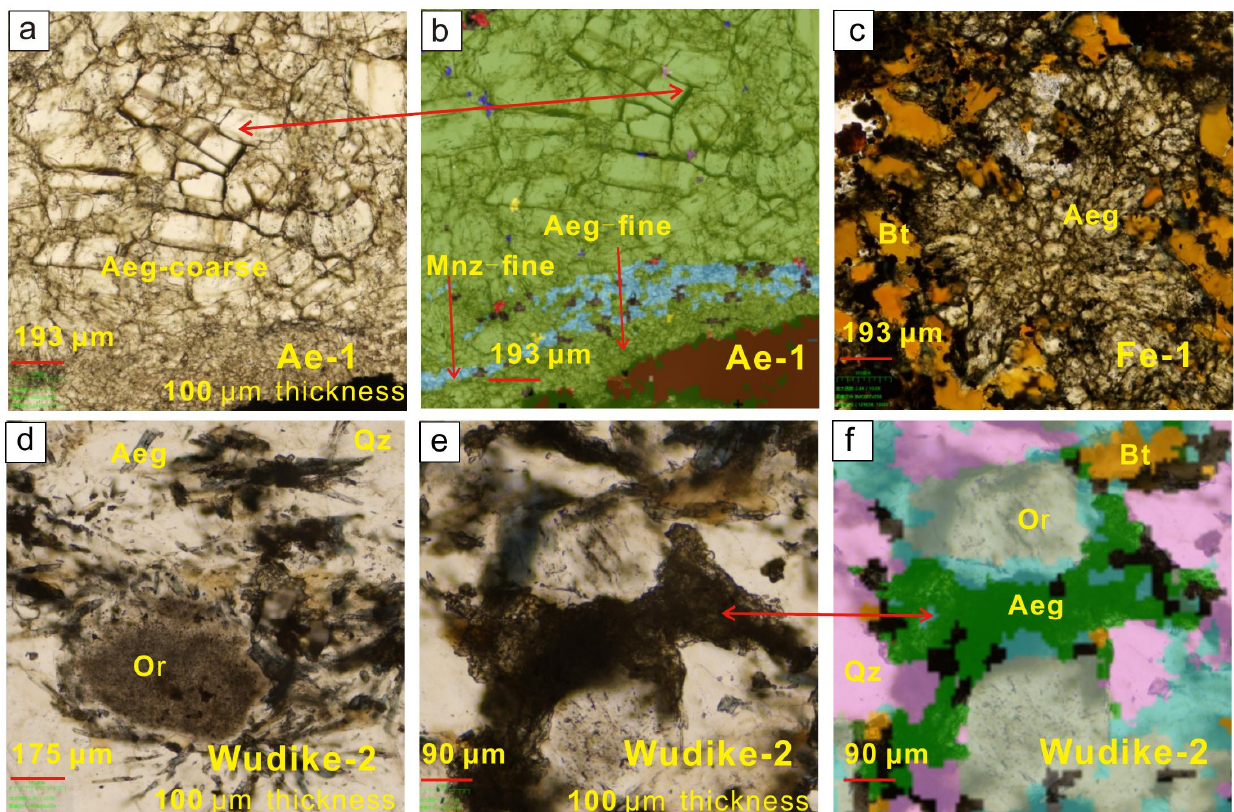
Figure 5. The petrological characteristics of aegirine. ( a , b ) Coarse and fine aegirine are common in green aegirine rock. ( c ) In the sample Fe-1, aegirine is often distributed with apatite and monazite pyrite, and the aegirine particles are mixed with impurities. ( d – f ) In Wu dike, aegirine shows acicular characteristics, which is very different from the characteristics of aegirine in the deposit. Aeg— Aegirine; Bt—Biotite; Mnz—monazite; Or—Orthoclase; Qz—Quartz.The mineral composition of B-2 has aegirine-augite (66.86%), pyrite (14.27%), aegirine (5.51%), calcite (3.72%), hematite/magnetite (1.54%), apatite (1.21%), quartz (0.99%), pyrrhotite (0.75%), and monazite (0.20%) (Figure 6). In the Bayan Obo deposit, aegirine-augite occurs in both the aggregate and columnar forms. In the aggregate type, single long (~0.2–1 mm) columnar crystals of aegirine constitute the aggregate, and the rock is dominated by aegirine (Figure 7a–c). Aegirine-augite also occurs as ~1.5 mm-long acicular and columnar forms in orthoclase (Figure 7d–f). Sample B-2 is an aggregate type with pyrite. Monazite occurs as inclusions in aegirine-augite and pyrite (Figure 3c).